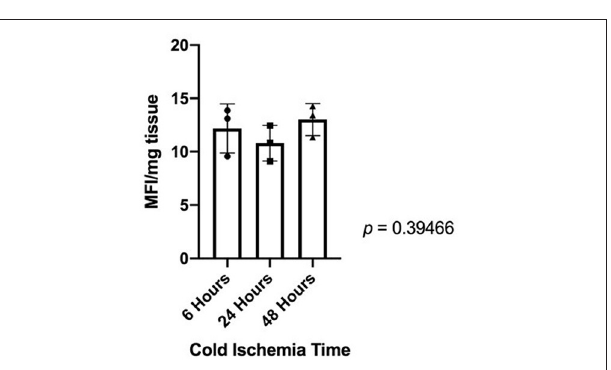
FIGURE 5 | Fluorescing resorufin quantification showed that there is no statistically significant difference in cellular metabolic activity between donor heart valves in cold storage for 6, 24, or